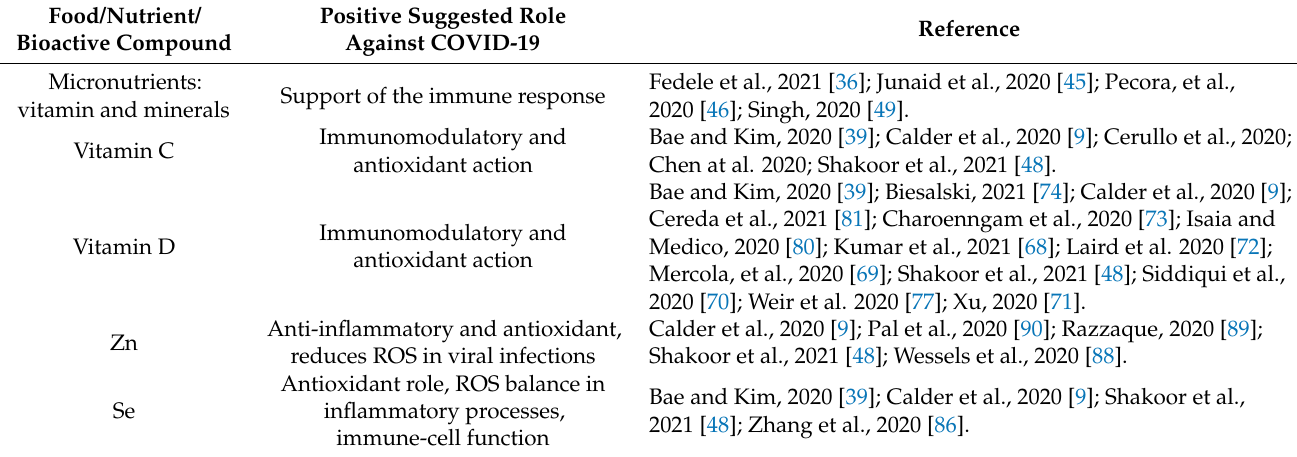
Table 4. Main reviews found in PubMed by using ‘immune system’, ‘food’, ‘food supplements’, and ‘COVID-19